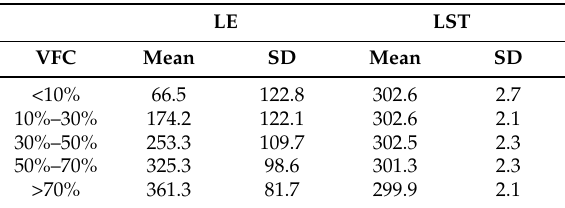
Table 5. Mean LE and LST of vegetation coverage categories.